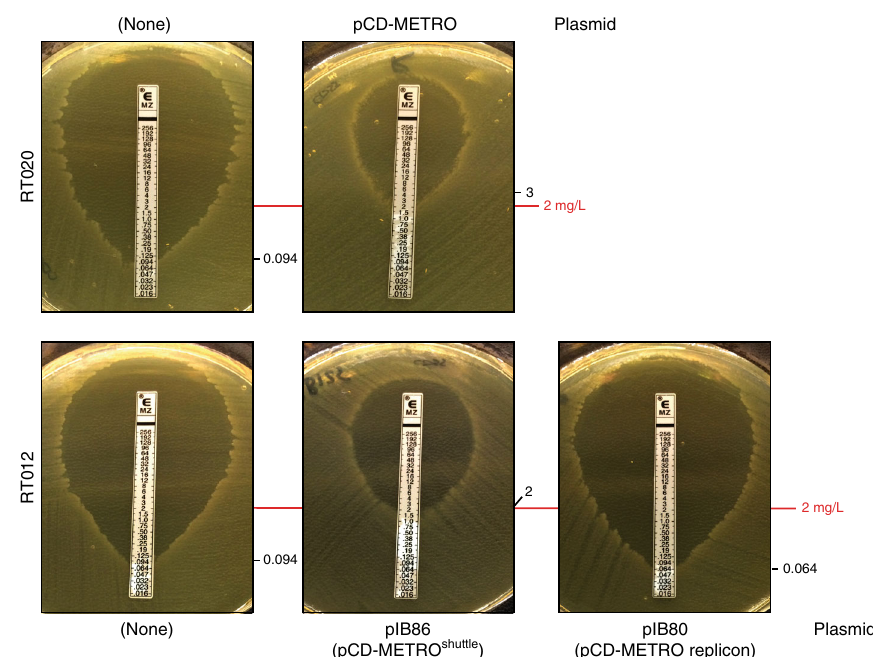
Fig. 6 pCD-METRO confers metronidazole resistance. RT020 without plasmid (MTZ S , strain IB132), RT020 with pCD-METRO (MTZ R , strain IB133), RT012 without plasmid (MTZ S , strain 630 Δ erm ), RT012 with pIB86 (pCD-METRO shuttle , MTZ R , strain IB125), RT012 with pIB80 (MTZ S , IB90; pIB80 contains the pCD-METRO replicon but lacks the other ORFs of pCD-METRO). IB90 and IB125 are 630 Δ erm -derivatives 49 . E -tests were performed on BHI agar plates with CDSS. Identical results were obtained on plates without CDSS. The images represent three independent repeats with a single replicate per condition. In all, 2 mg L − 1 indicates the EUCAST epidemiological cutoff for metronidazole that was used to de fi ne resistance in this study 32 . E -test values for the indicated strains are shown next to their respective panels. Source data are provided as a Source Data fi le.